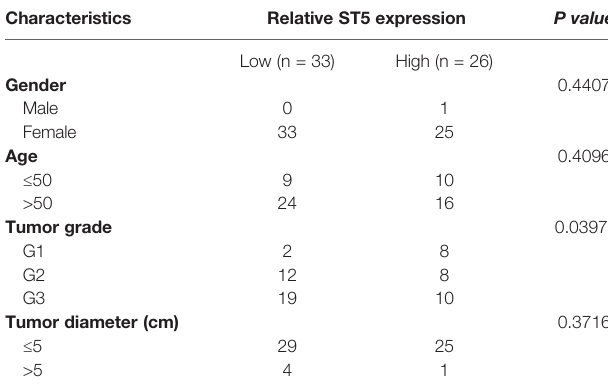
TABLE 1 | Chi-squared analysis of contingency tables between ST5 status and clinicopathological characteristics of Breast Cancer patients.